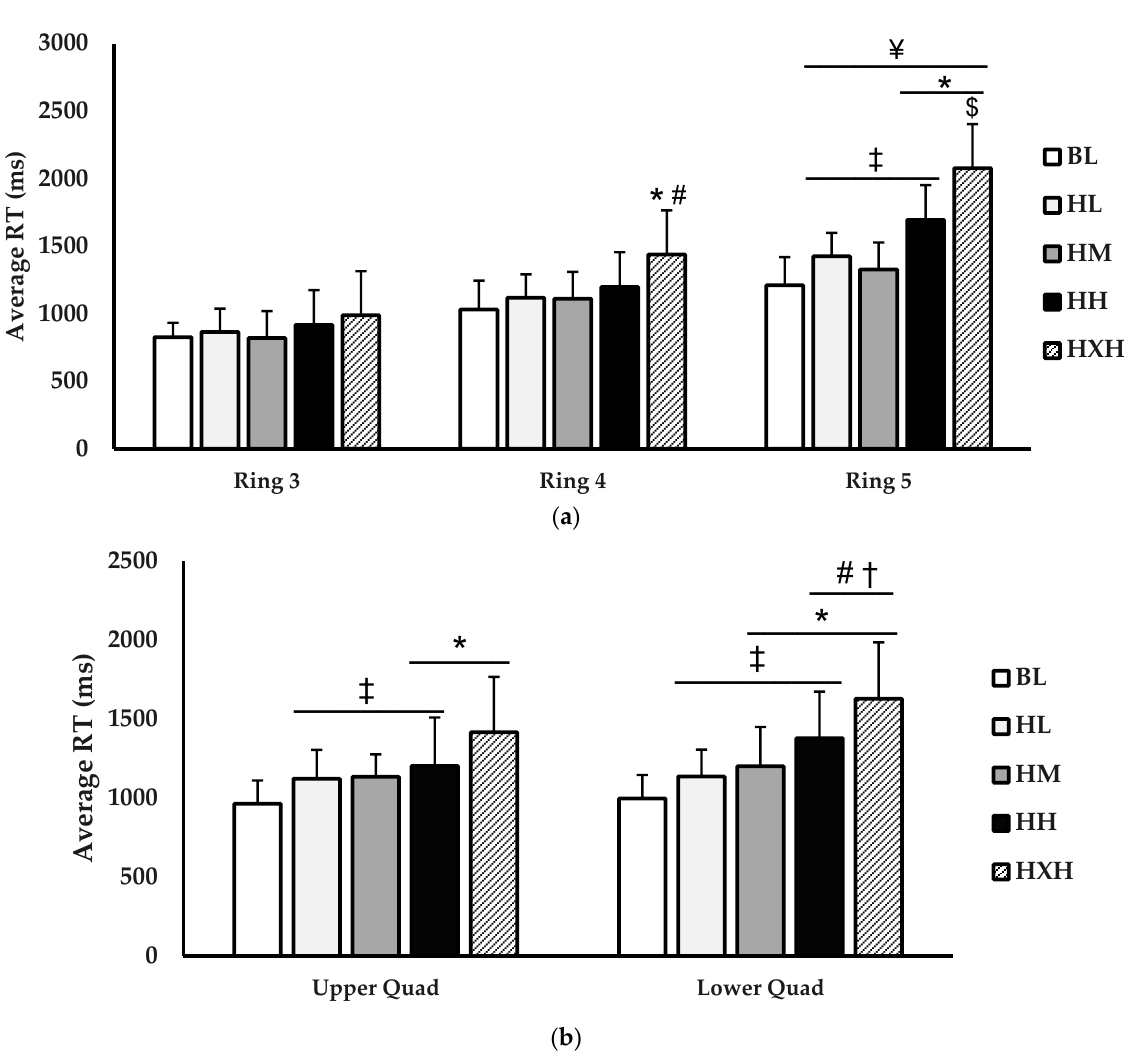
Figure 4. Comparison of ( a ) reaction time (ms) separated by rings (ring 3, ring 4, ring 5), ( b ) reaction time (ms) separated by upper and lower quadrants between baseline (BL; white), helmet + light facemask (HL; light grey), helmet + medium facemask (HM; grey), helmet + heavy (HH; black), and helmet + extra heavy (HXH; black striped) conditions. Data are presented as mean ± SD. * indicates significant difference from baseline ( p < 0.05). ‡ indicates significant difference from HXH ( p < 0.05). # indicates significant difference from HL ( p < 0.05). † indicates significant difference from HM ( p < 0.05). ¥ indicates significant difference from ring 3 ( p < 0.05). $ indicated significant difference from ring 4 ( p < 0.05).